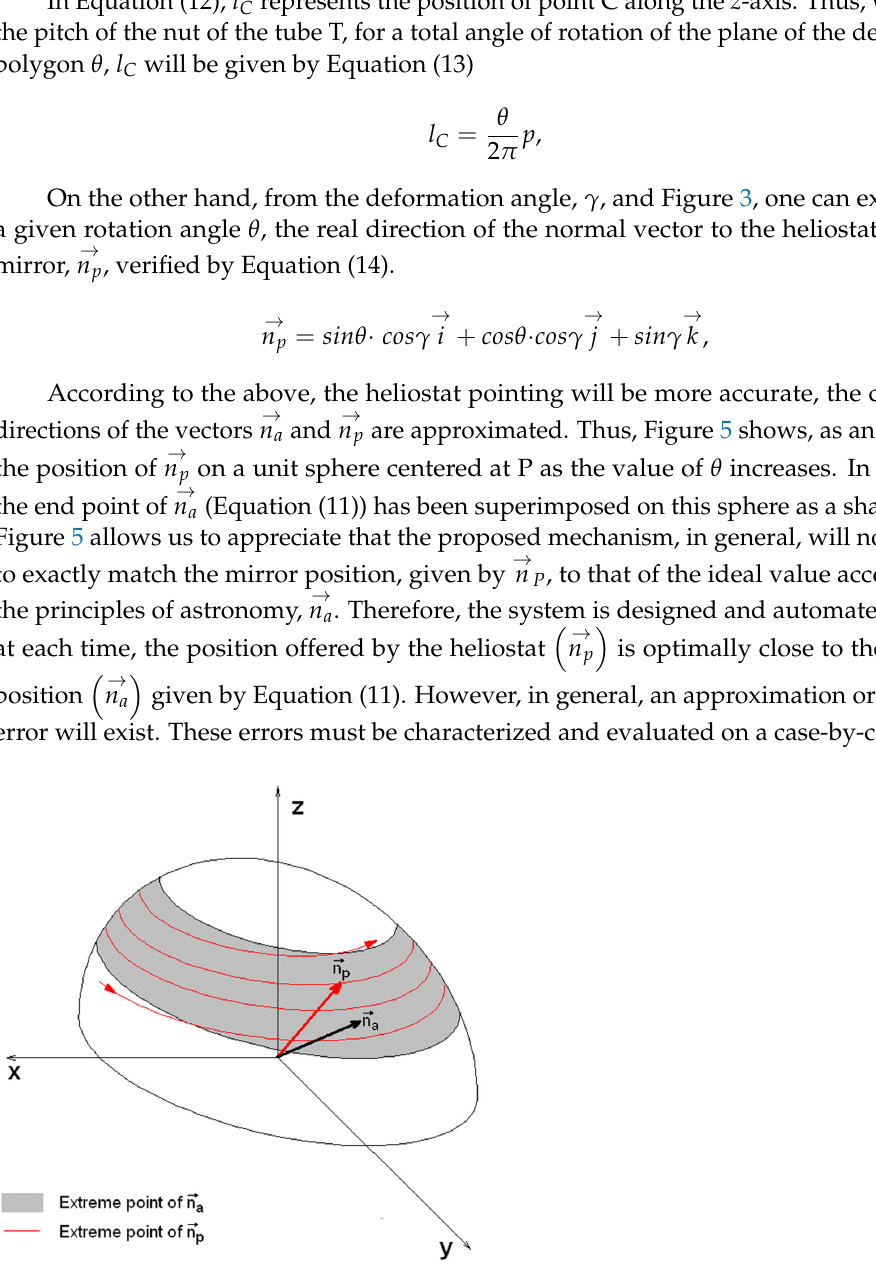
Figure 5. Graphical comparison between the possible positions for 𝑛(cid:4652)⃗ (cid:3017) and 𝑛(cid:4652)⃗ .